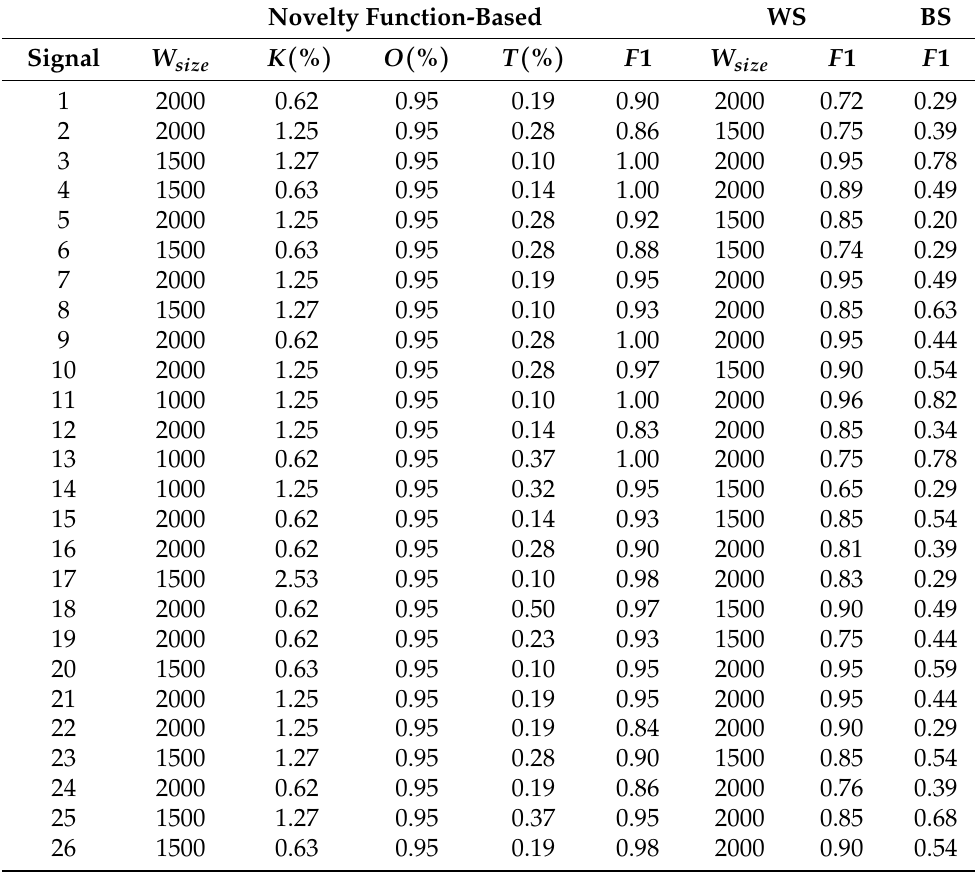
Table A5. Parameter configuration and experimental results of each signal in Dataset 4 (EMG, see Section 3.4). W size : window size; K %: kernel size in percentage of the window size; O %: overlap percentage of the window size. T %: amplitude threshold for event detection; WS: window-based segmentation; BS: binary segmentation. The tolerance used to calculate the F1-score ( F 1) equals the window size for novelty function